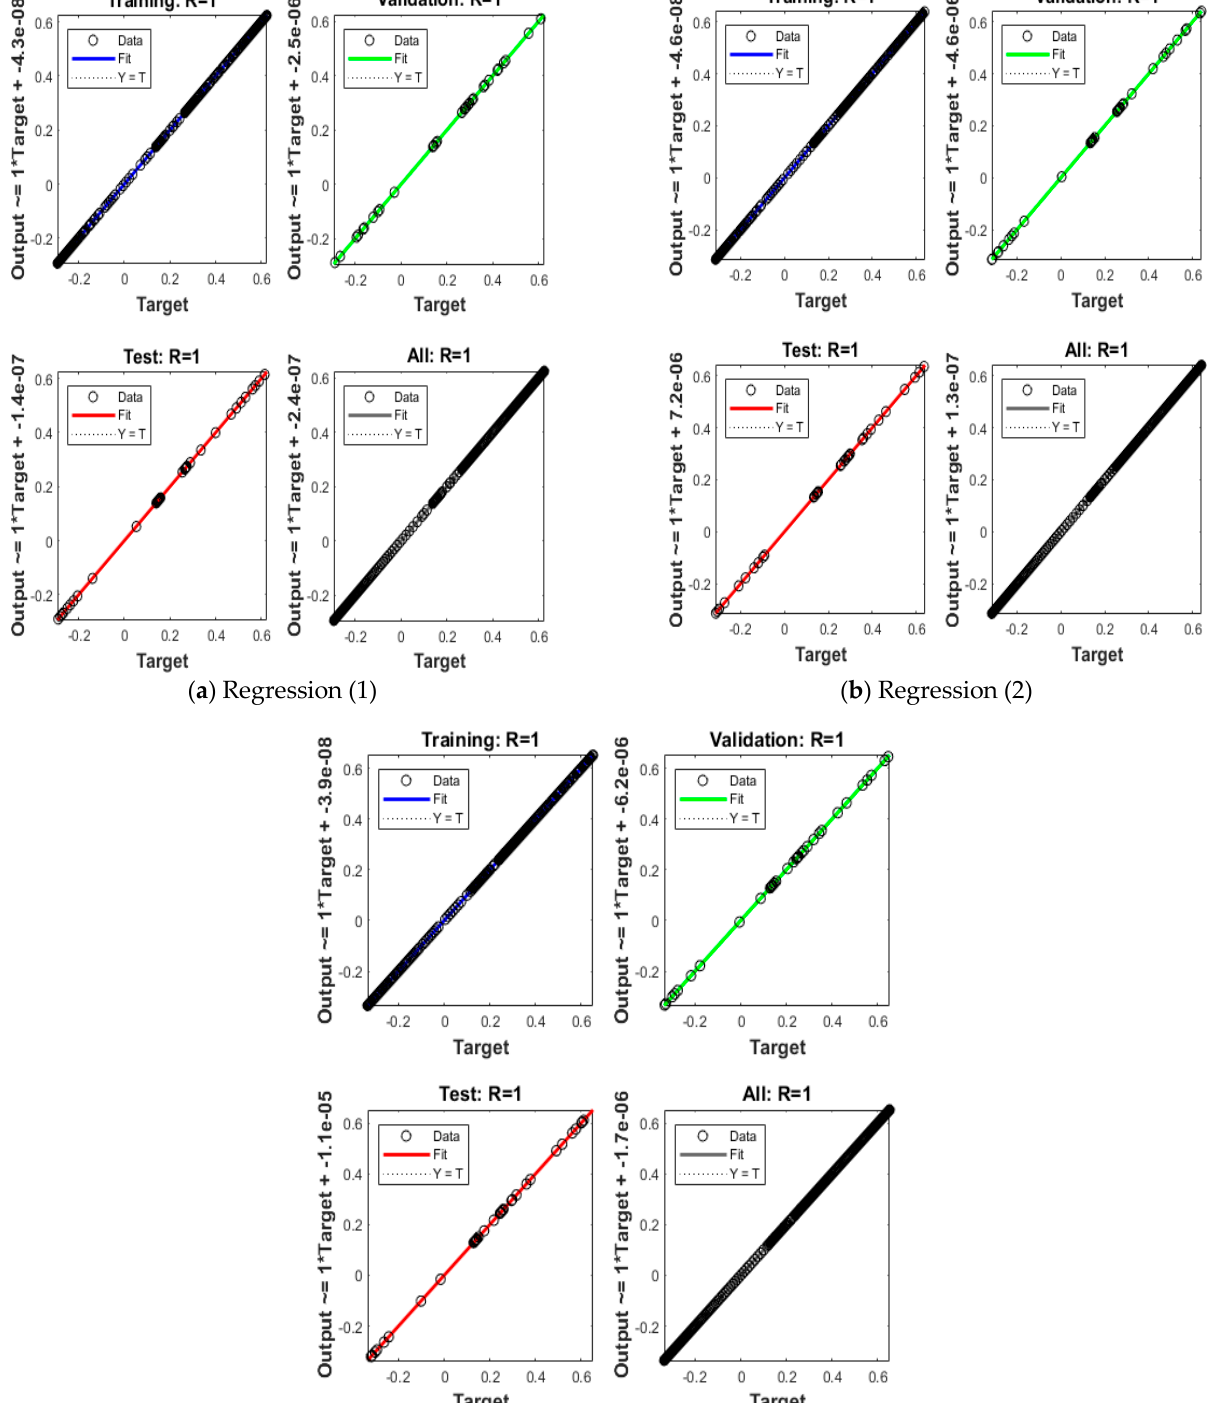
Figure 4. Assessments of the outcomes along with the EHs to solve the FO-MML love story model.